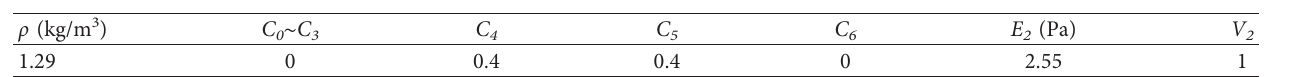
Table 2: Parameters of air.